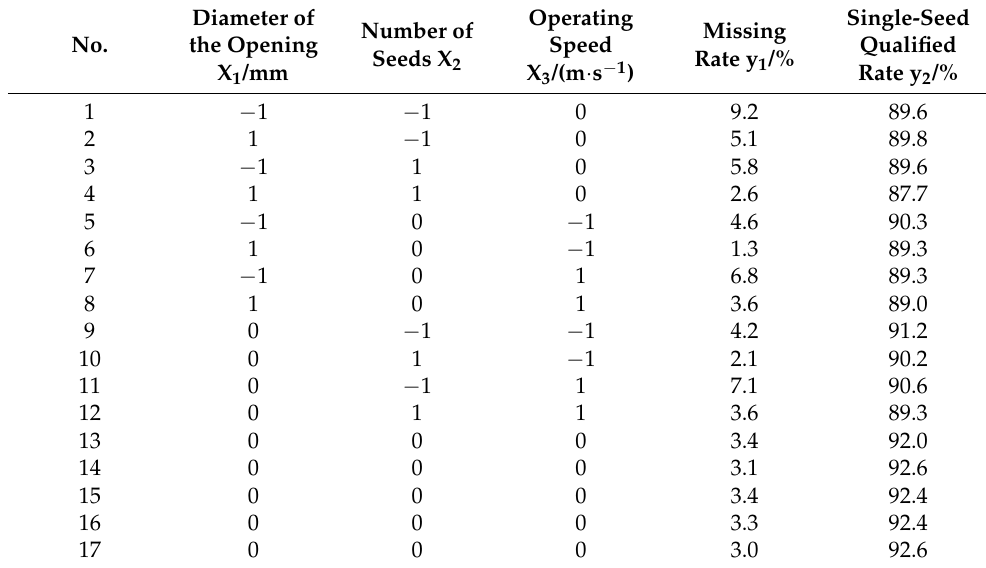
Table 5. Experiment design and results.